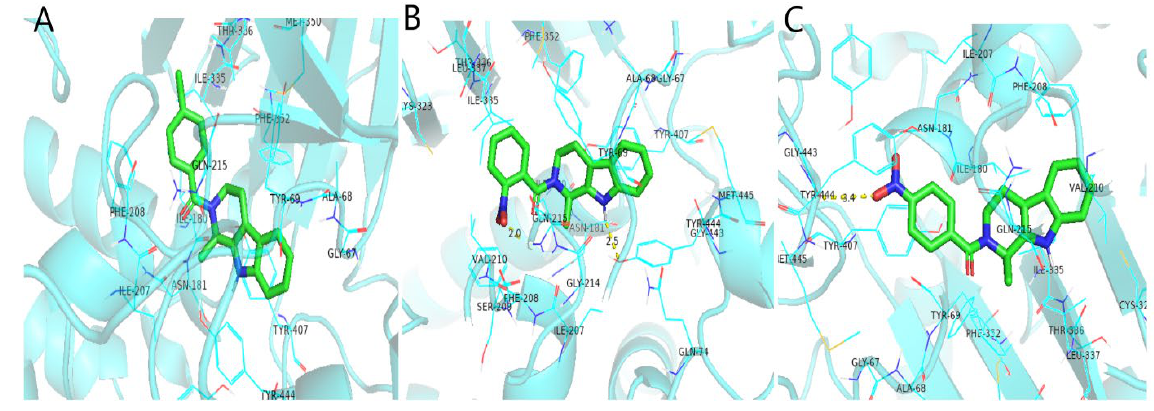
Figure 6. Schematic diagram of compounds 11b ( A ), 11f ( B ) and 11g ( C ) binding to Amine oxidase [flavin-containing] A protein.